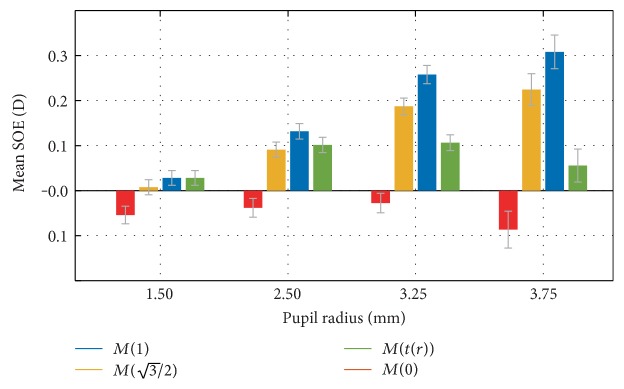
Application of the four MTR metrics to an independent IND dataset (Indiana in Table 1). The error bars represent ±1 SEM.